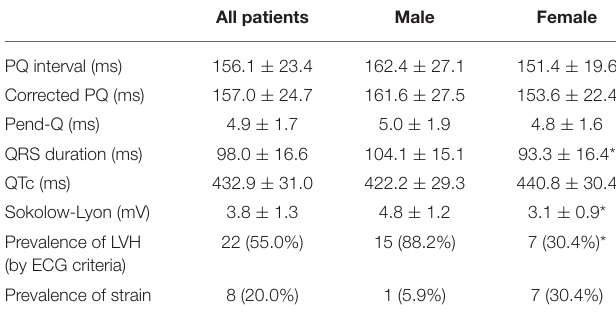
TABLE 1 | Baseline characteristics. TABLE 2 | Baseline ECG